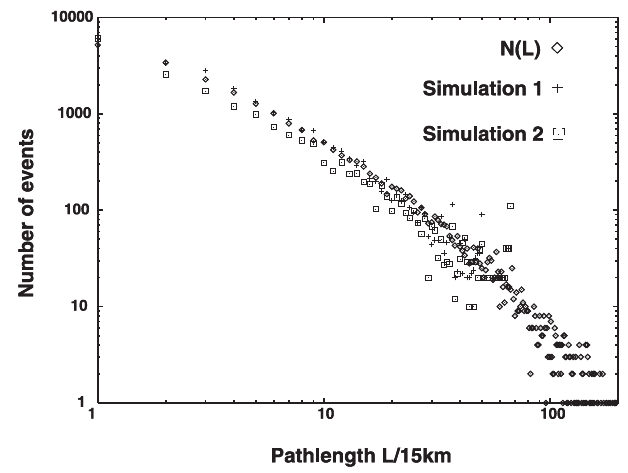
Fig. 5. Frequency distribution of path lengths inside ISSR according to two di(cid:128)erent numerical simulations using circular ISSRs with diameters distributed according to a generalised gamma-density, compared to the original data, N (cid:133) L